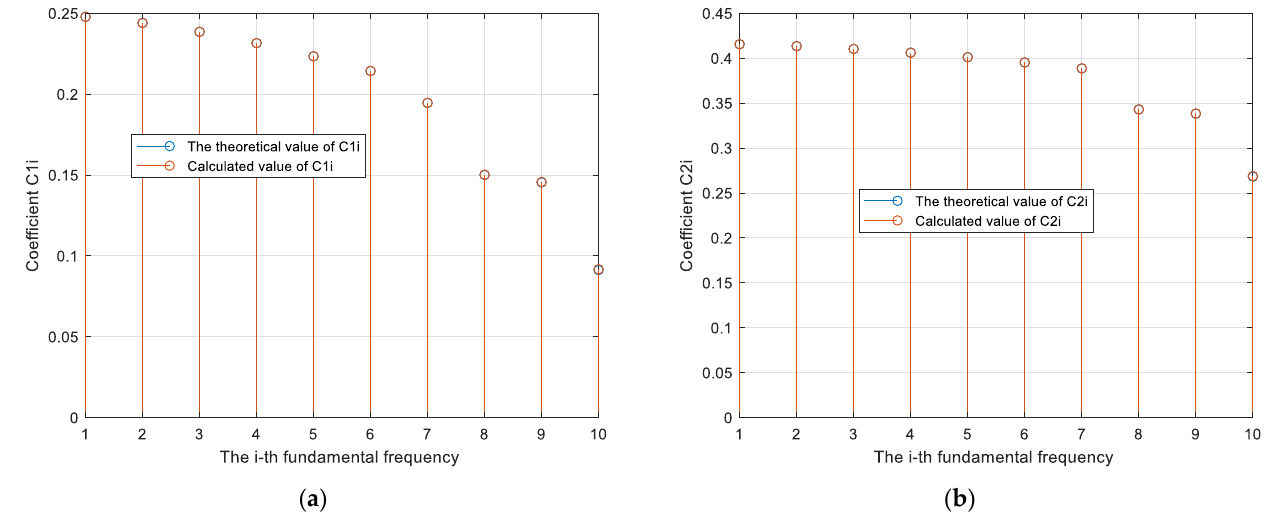
Figure 2. ( a ) The theoretical value and calculated value of C 11 i ; ( b ) the theoretical value and calculated value of C 21 i .